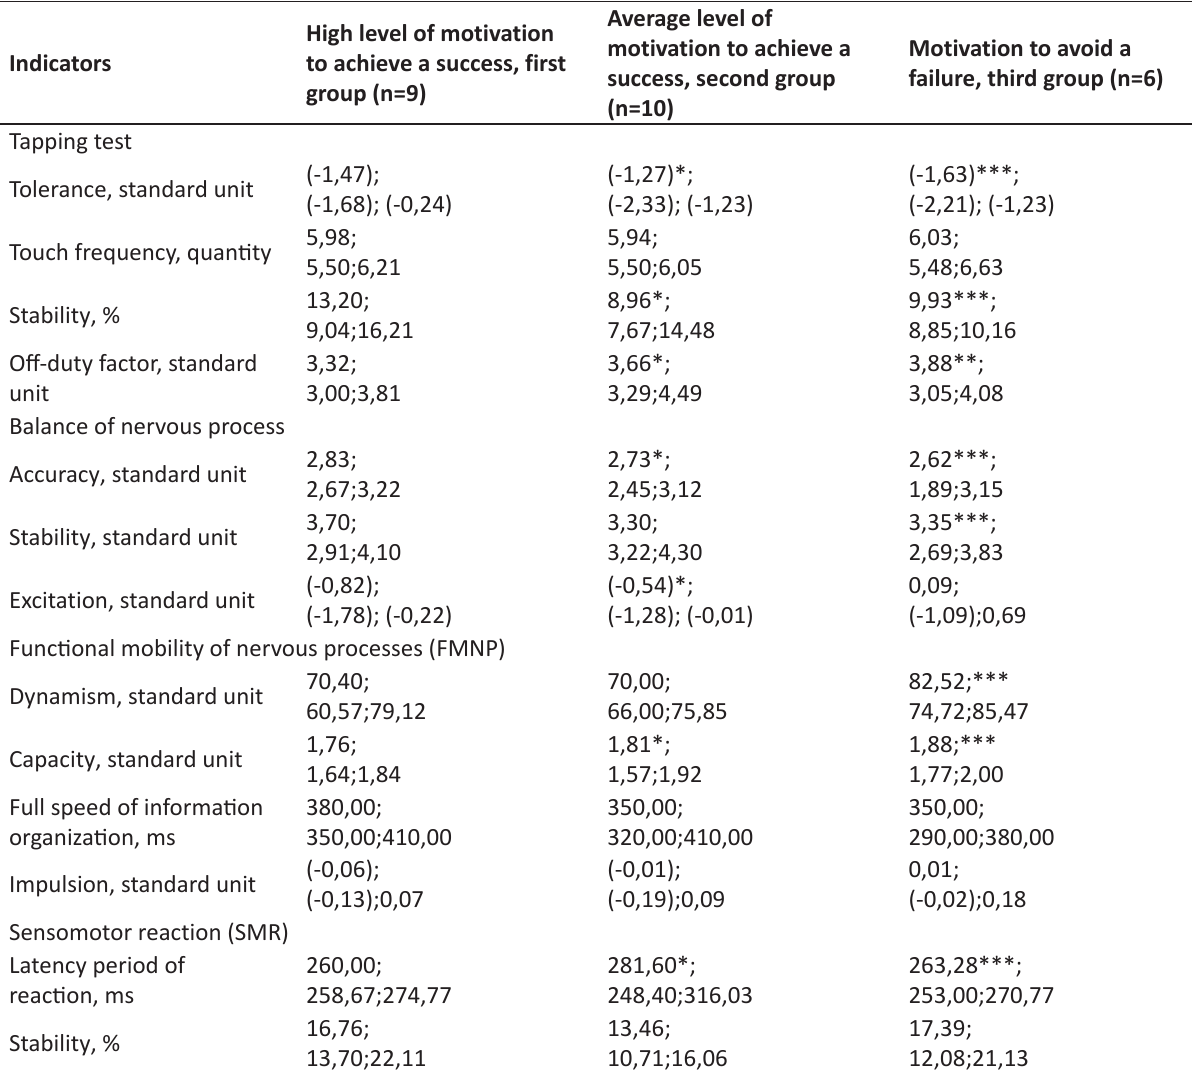
Table 1. Neurodynamic and psychomotor characteristics of high qualification judo athletes with different levels of motivation (median, lower quartile, upper quartile)